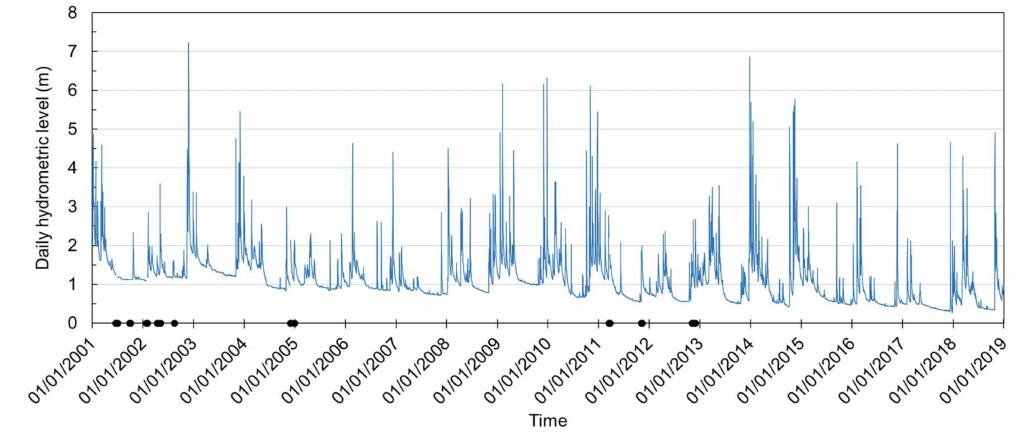
Figure 2. Mean daily hydrometric level measured at the Guazzora gauge station from 2001 to 2018. Black dots on x -axis highlight missing data in the time series. The 2011 extreme flood is not